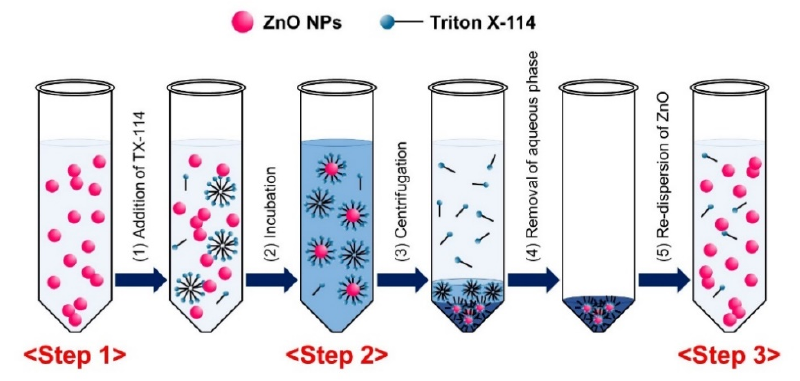
Figure 1. Schematic illustration of Triton X-114 (TX-114)-based cloud point extraction (CPE) procedure.